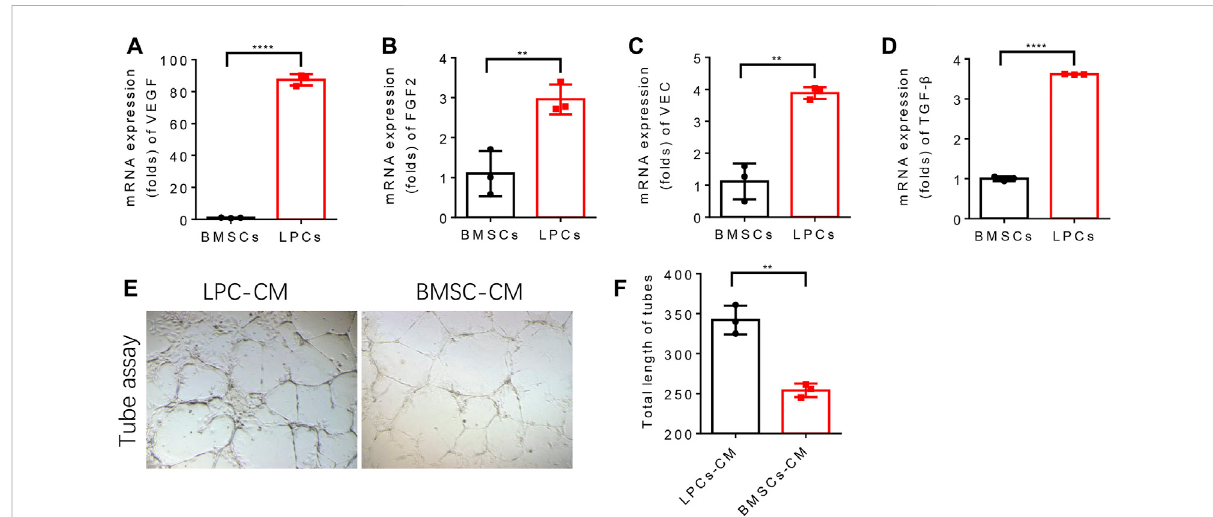
FIGURE 2 LPCspromoteangiogenesisofendothelialcellsbyparacrine. (A – D) QuantitativeanalysisofthemRNAexpressionofVEGF,FGF2,VEC,TGF- β in BMSCs and LPCs. ** P ＜ 0.0001. (E) Representative microphotographs of capillary-like tubes formed by induced HUVEC cells on Matrigel in the presence of BMSCs or LPCs conditioned media. (F) Quantitative analysis of the total length of the tubes structure in BMSCs or LPCs conditioned media treated groups (Pixels). ** p =